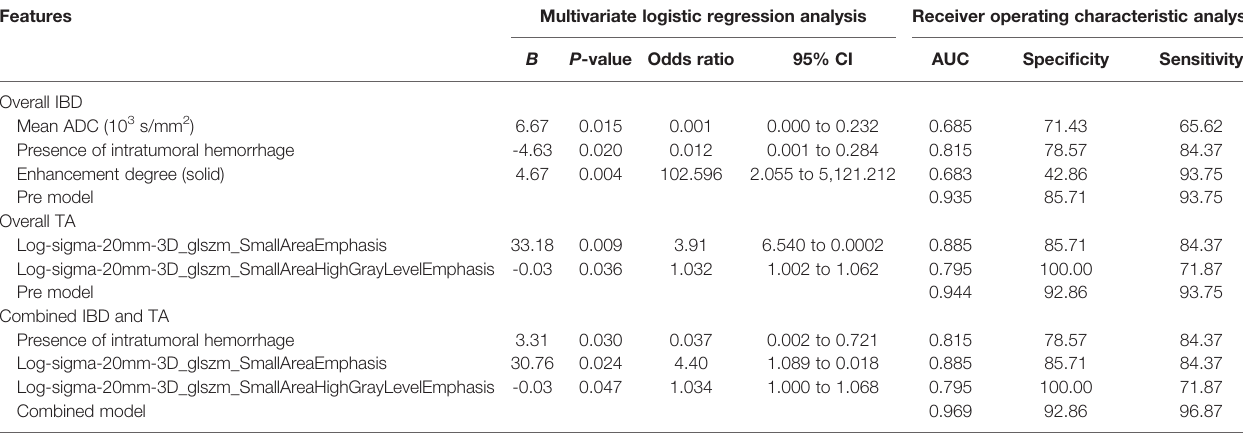
TABLE 5 | Multivariate logistic regression and receiver operating characteristic curve analysis for the overall IBD, overall TA, and combined IBD with TA models. Features Multivariate logistic regression analysis